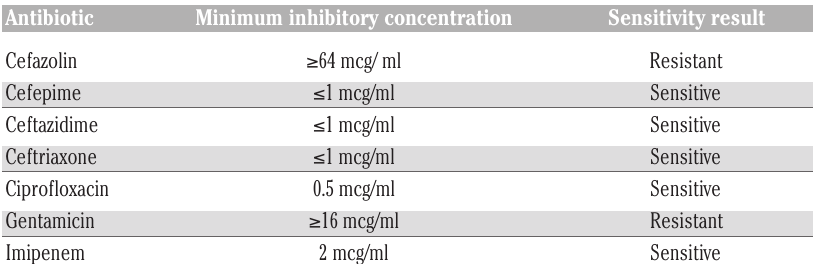
Table 1. Sensitivities of Citrobacter freundii , isolated in our patient with peritonitis.